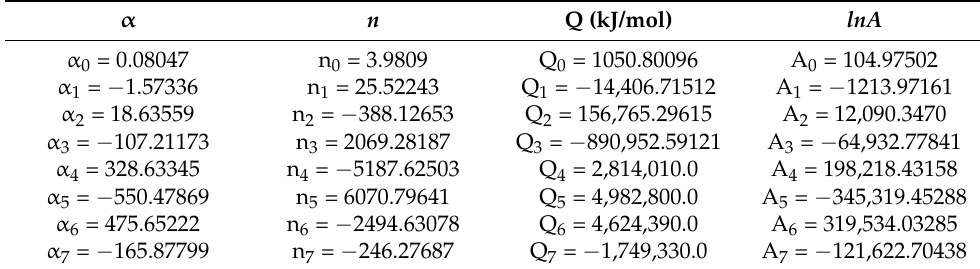
Table 3. Data of material constants ( α , n, Q, and lnA